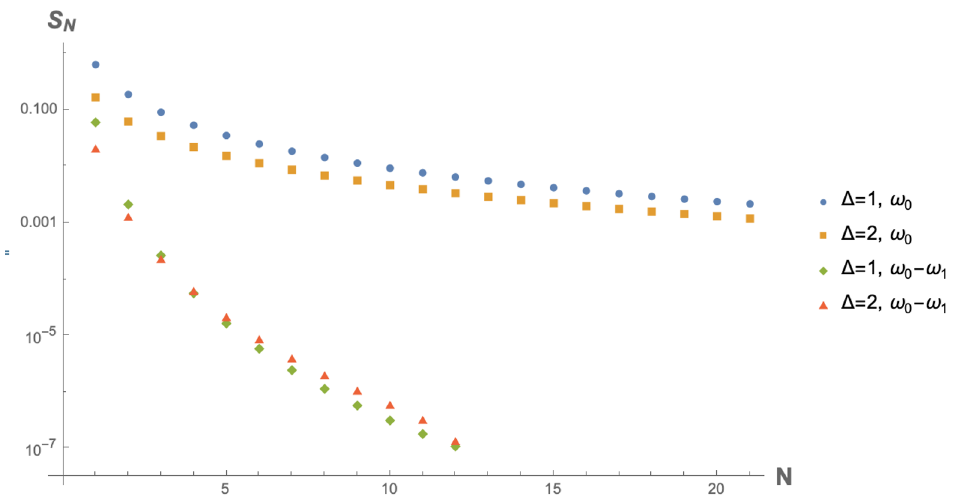
Figure 3 . L = 0 sum rules for external dimensions ∆ φ = 1 , ∆ φ = 2 and different functionals ω 0 and ω . The plot shows the value of the finite sum truncated after N terms in a logarithmic 0 − ω 1 scale. The better convergence is seen for the ω functional, due to a better large s 0 − ω 1